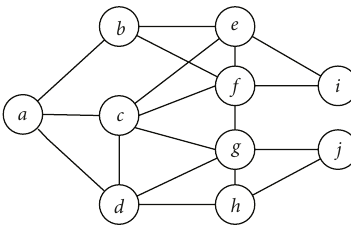
Figure 1: Topology of visual sensor networks. Circles depict cameras; edges depict path between